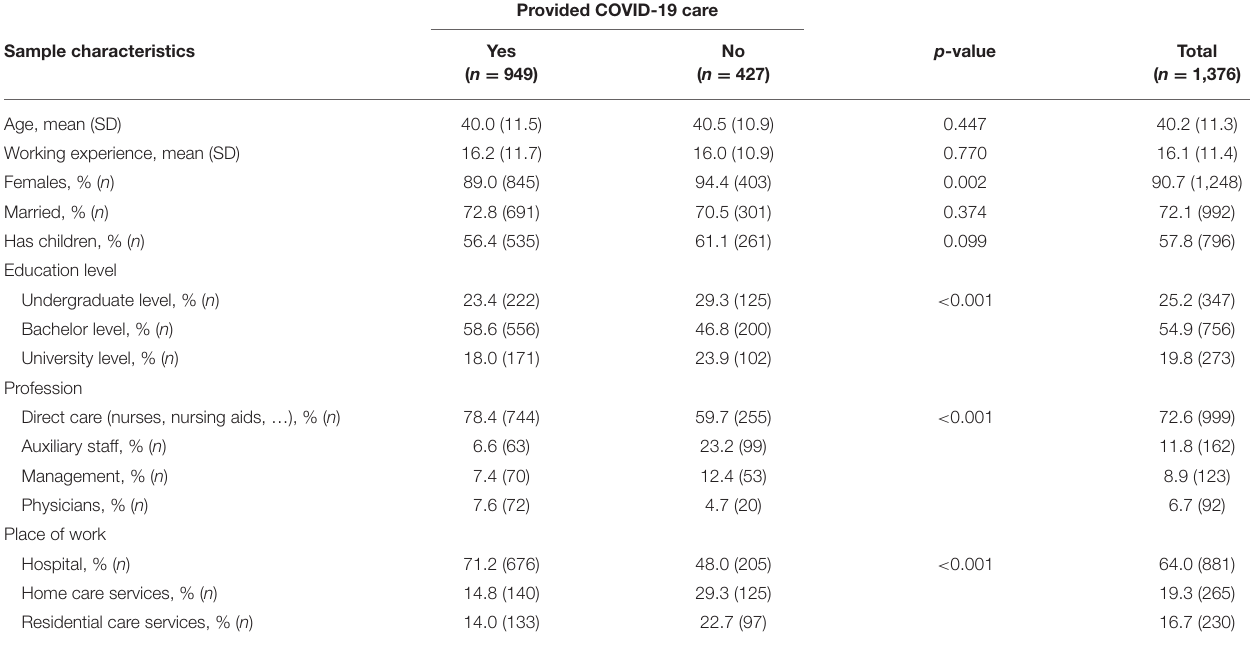
TABLE 1 | Sample characteristics in total and compared between COVID-19 and other